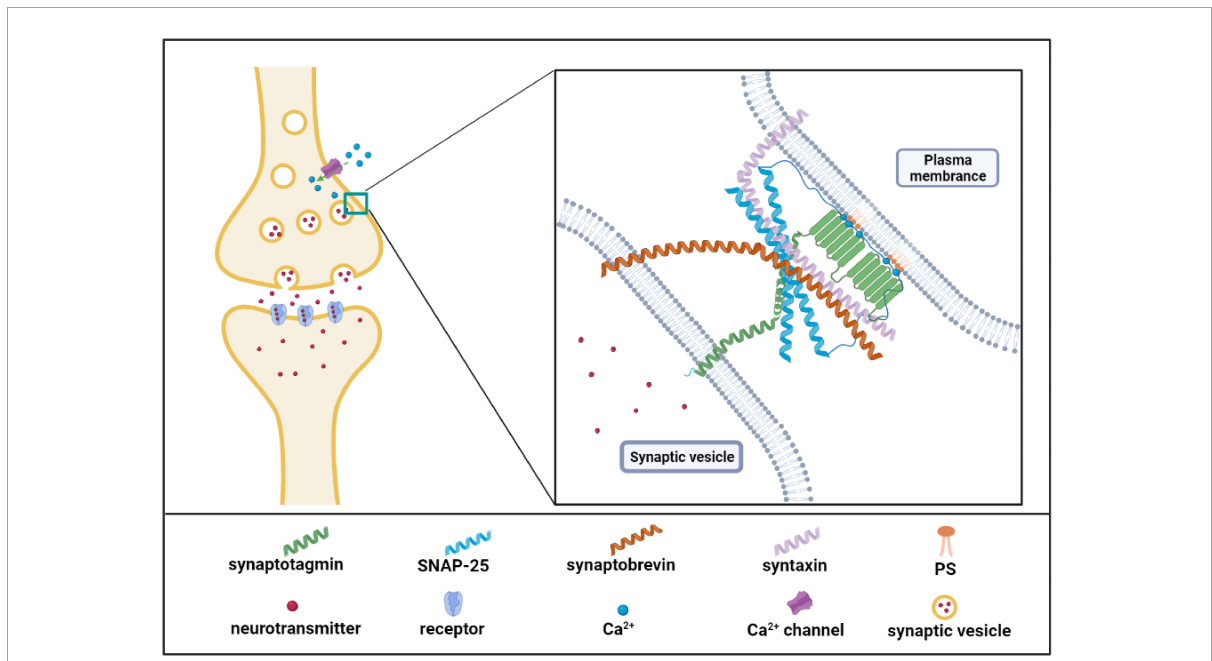
FIGURE3 Phosphatidylserine (PS) effector protein synaptotagmin I is involved in neurotransmitter release. As the figure shows, synaptotagmin I possesses two C2 domains to bind Ca 2 + and PS. N-terminus of synaptotagmin I is in synaptic vesicles and C2 domain in cytoplasmic. Synaptotagmin I binds Ca 2 + when Ca 2 + flows into cells from the Ca 2 + channels. The Ca 2 + binding further increases the binding of synaptotagmin I to SNARE complex as well as the fusion of synaptic and plasma membrane. SNARE complex includes the synaptosome-associated protein of 25 kDa (SNAP25), synataxin, and synaotobrevin. Created with